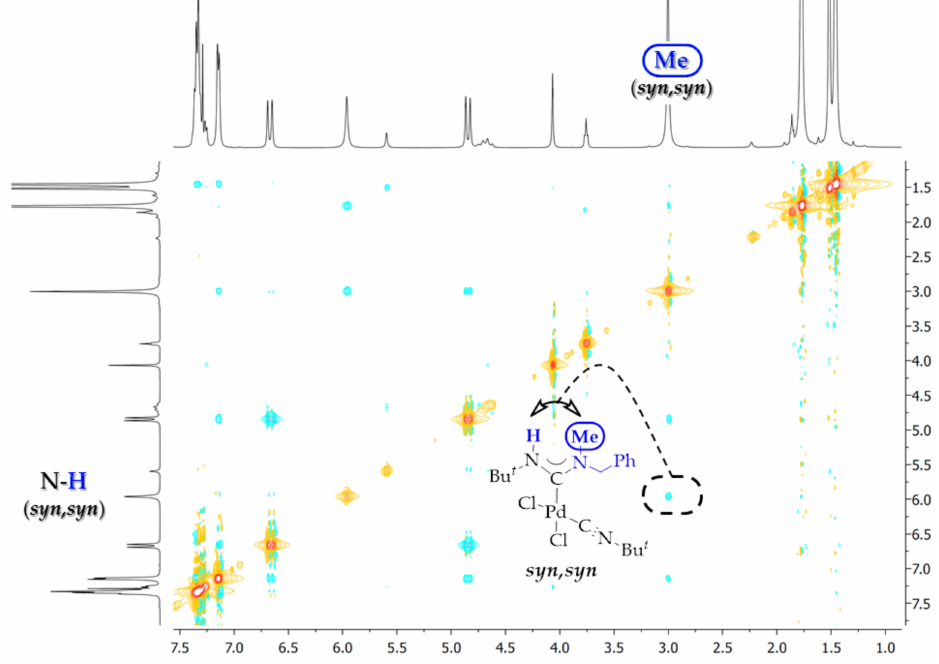
Figure 9. ROESY spectrum of 8 at − 50 ◦